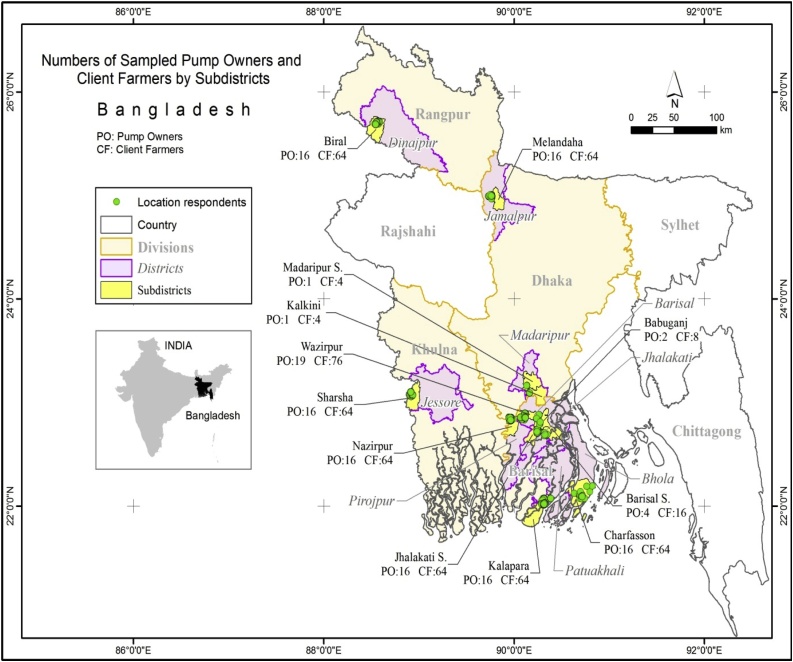
Survey locations and the numbers of sampled pump owners and client-farmers by sampled sub-districts, Bangladesh.